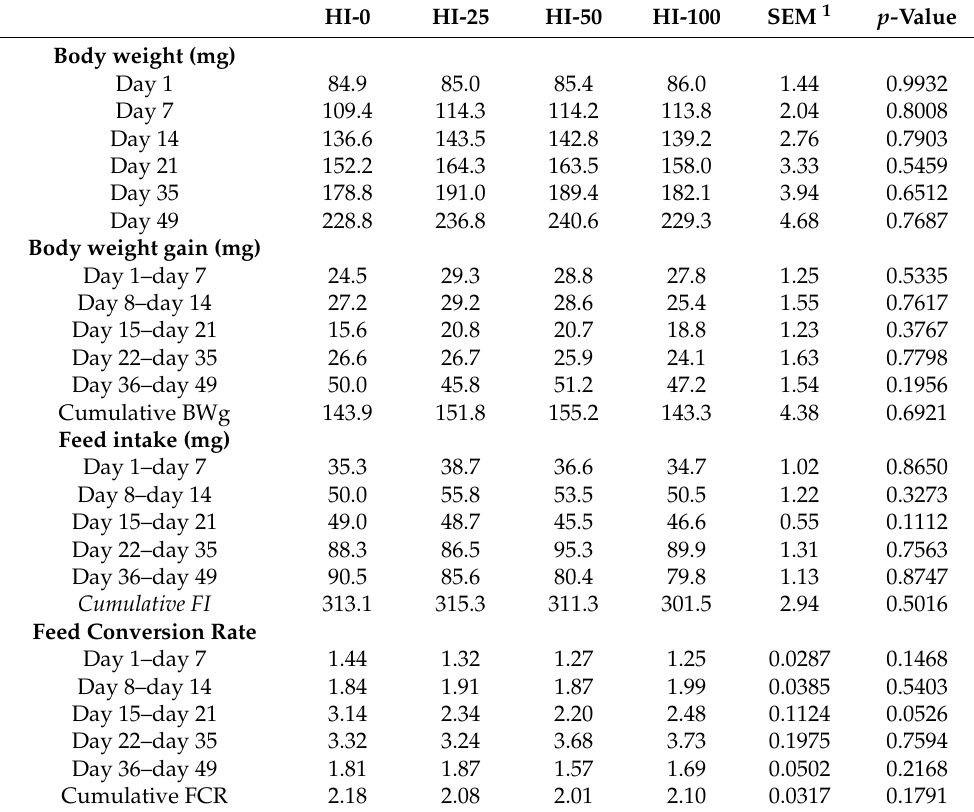
Table 3. Growth performance parameters in relation to FM replacement rate with HIM.